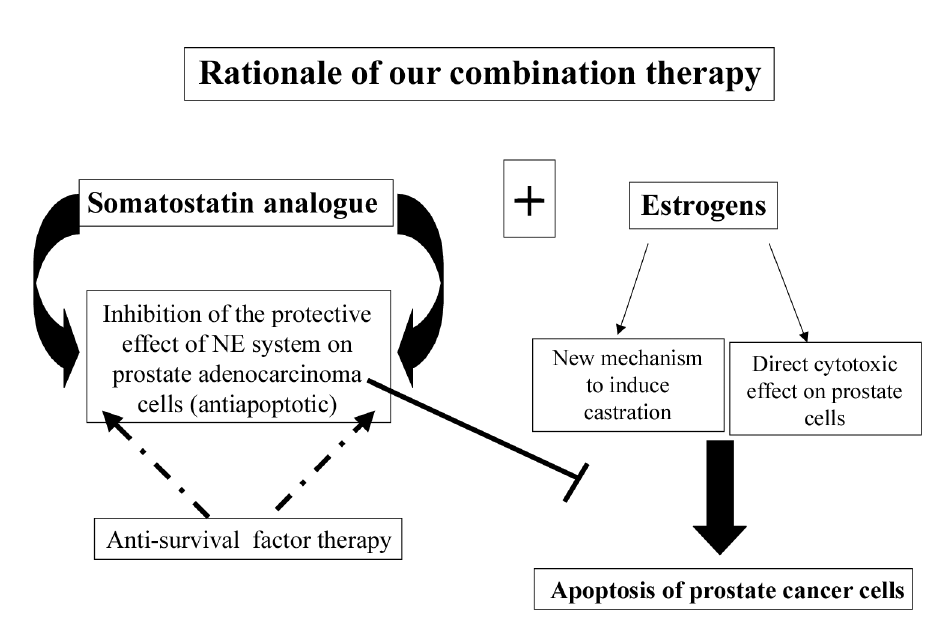
Figure 4 – Antisurvival combination therapy for advanced prostate